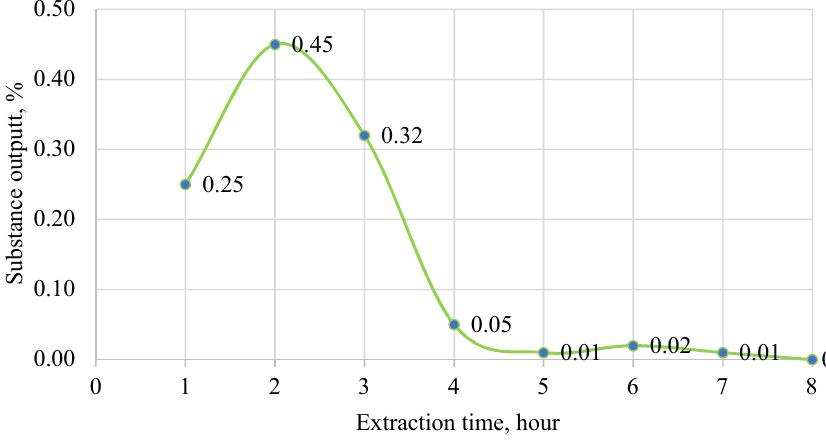
Fig. 8. The plot of essential oil yield versus extraction